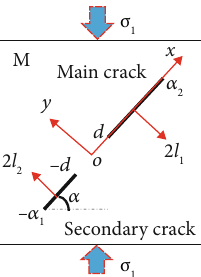
Figure 4: Mechanical model of unequal collinear cracks under uniaxial